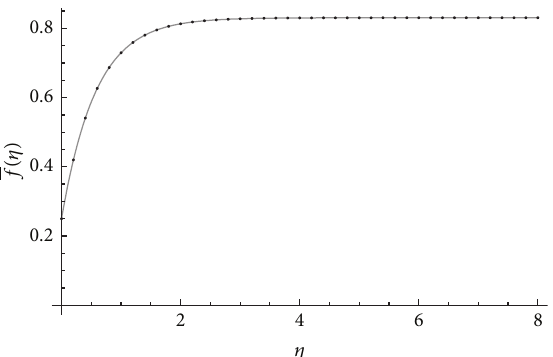
Figure 1: Comparison between the approximate solution (46) and numerical solution in the following cases: 𝛽 = 0.5 , 𝑀 = 0.75 , and 𝑅 = 0.25 —numerical solution; ......... approximate solution.